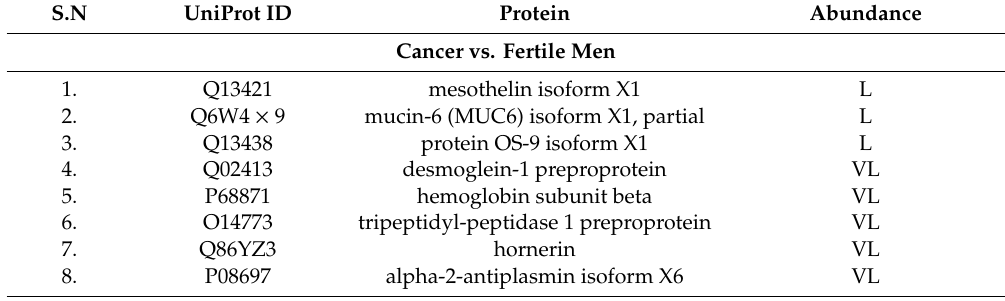
Table 2. Sperm proteins uniquely expressed in the cancer group compared to fertile men.